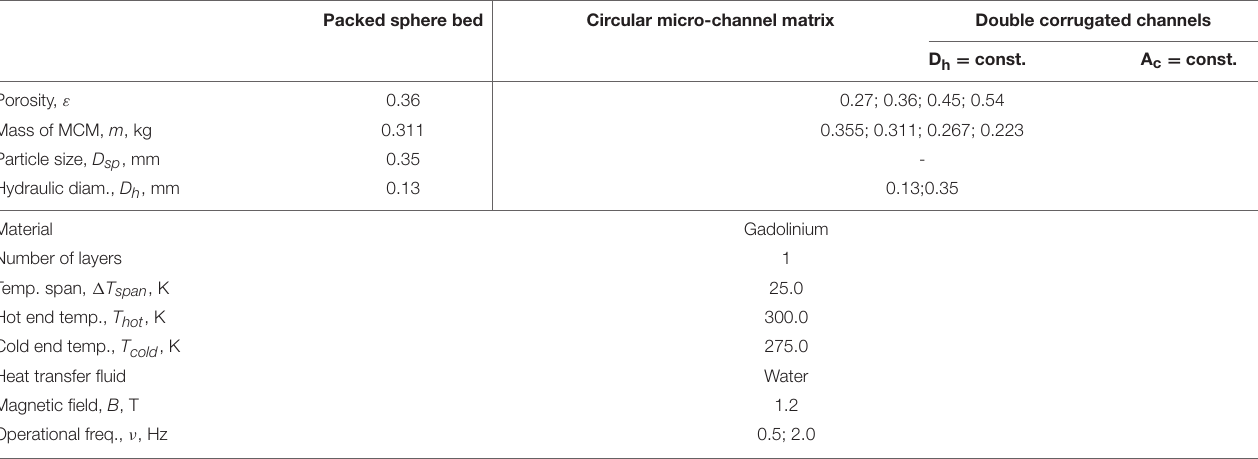
TABLE 3 | Material properties and boundary conditions for the 1D AMR model. Packed sphere